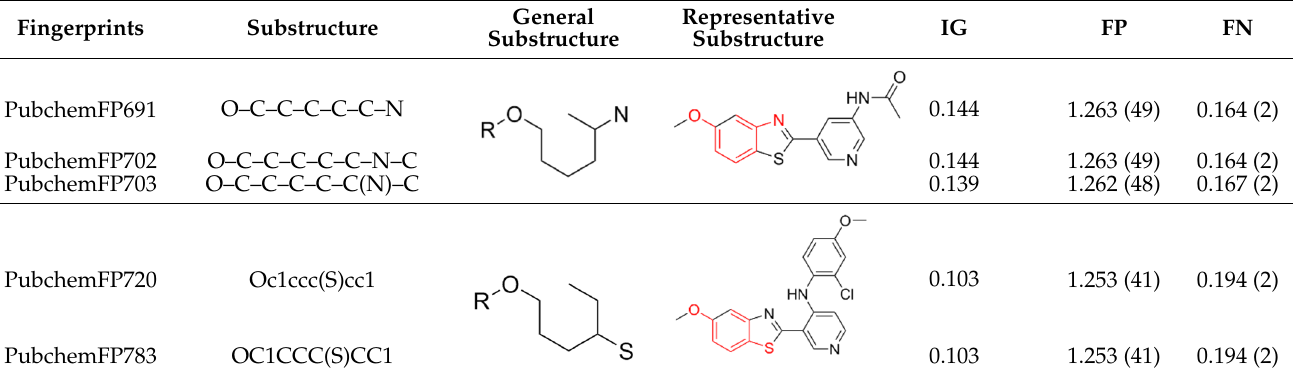
Figure 3. Proposed binding modes of ( A ) compound 73 and ( B ) compound 23 with DYRK1A. Fragment-based drug design including fragment-based growing and/or linking strat- egies and fragment hybridization strategies has been widely used in drug discovery by assembling fragments into novel molecules. Here, the privileged substructures above- mentioned provide structural elements for the discovery of DYRK1A inhibitors. AlNajjar et al. [21] reported that 6-hydroxybenzothiazole urea derivatives b27 displayed the high- est potency against DYRK1A with an IC 50 of 20 nM, which could be considered as an ac- etamide group-based linking compound by connecting 6-hydroxybenzothiazole and a phenyl acetamide together. Docking results indicated that hydrogen bonds were formed site of DYRK1A including acetamide groups with the hinge region backbone of Leu241